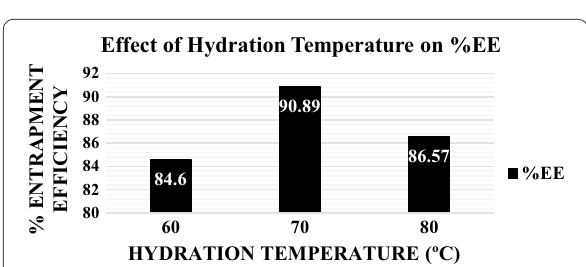
Fig. 5 Graphical comparison of effect of hydration temperature on %EE